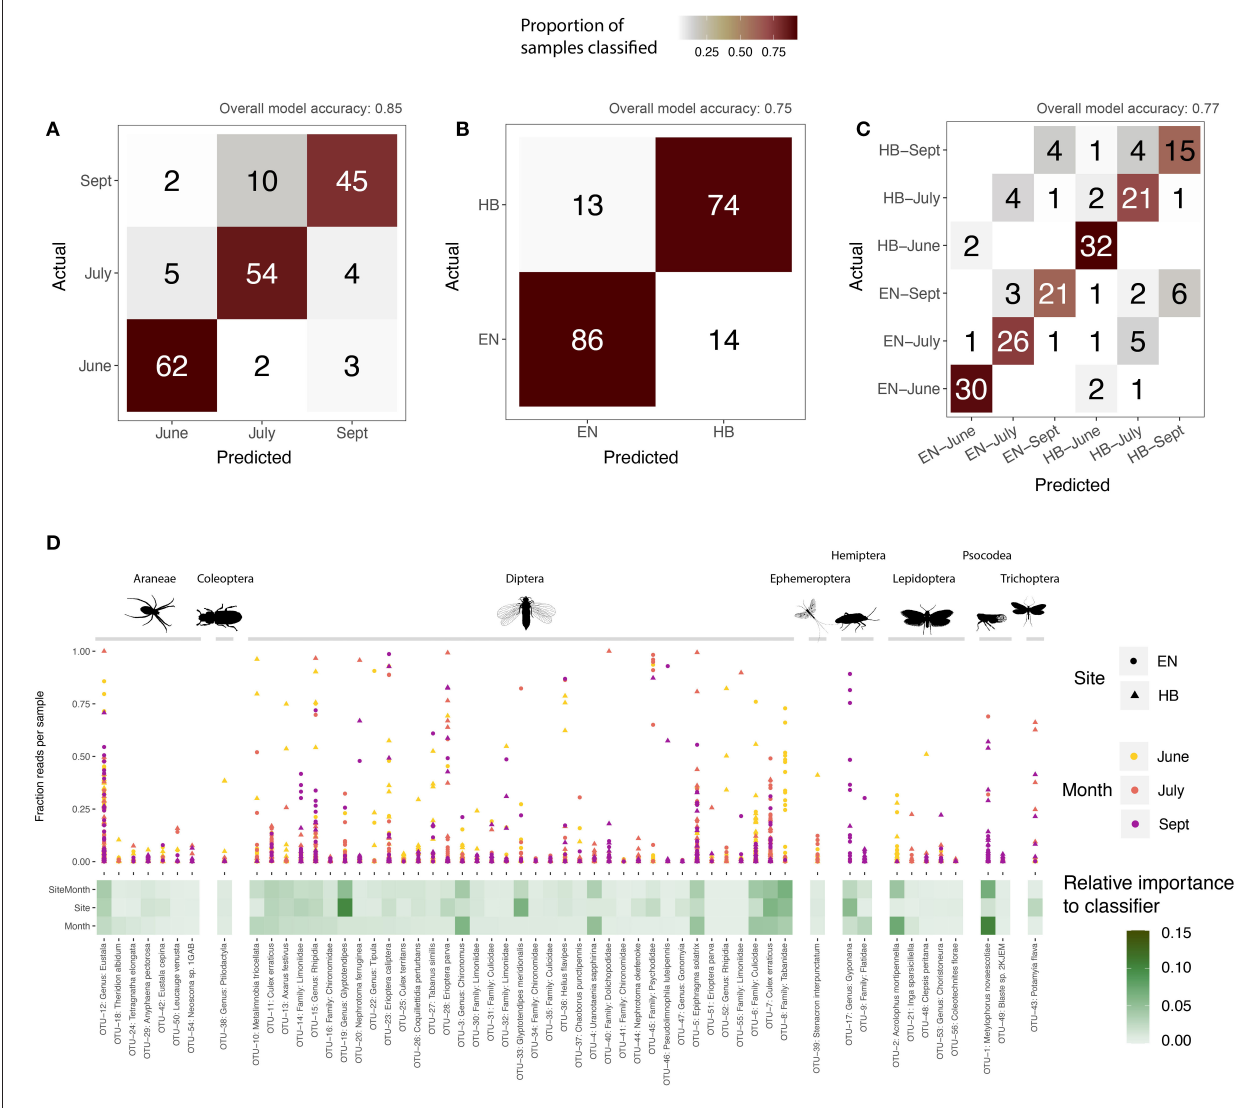
FIGURE 4 | Supervised learning of core sequence clusters (OTUs) using Random Forest classifiers. Confusion matrices illustrate model accuracy, showing the number of samples predicted for each group: (A) sampling month; (B) sampling site (Egner, “EN”; Hickory Bottoms, “HB”); (C) sampling site and month. Overall accuracy for each model shown at top of confusion matrix. The relative importance of each OTU, for each model, is shown in (D) , along with the proportion of sequences comprised of that OTU for each sample, defined by its sampling site and